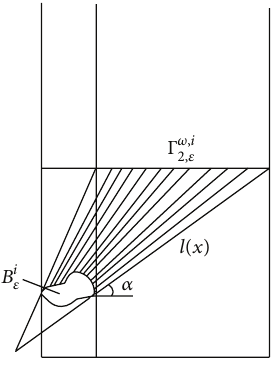
Figure 3: Tangential